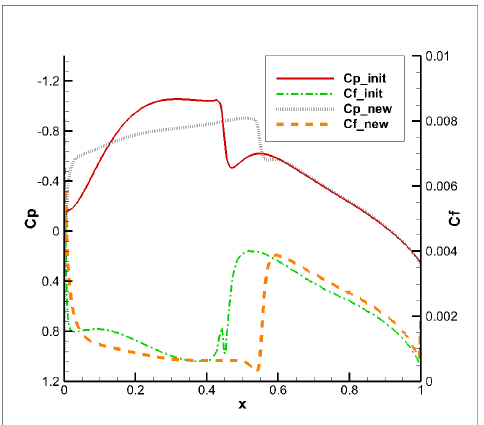
Figure 10. The pressure coefficient contour of the initial and optimized airfoil (i.e., candidate no. 5 in Figure 9).